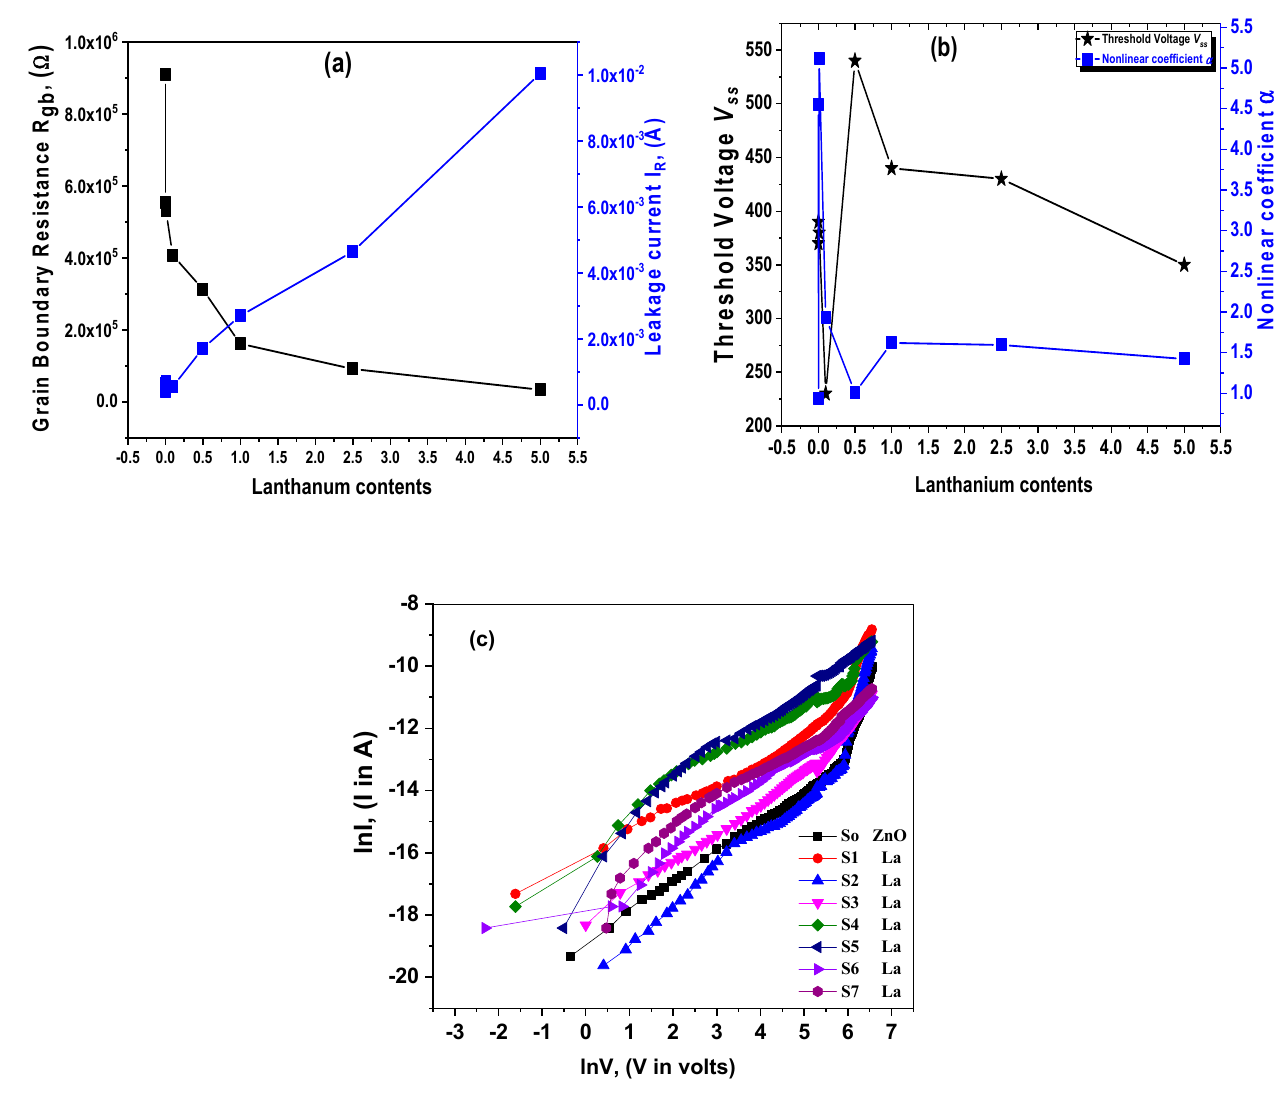
Figure 8. ( a – c ): ( a , b ) The V–I fitted as a function of the lanthanum contents, ( c ) linear relation between lnI and lnV as-prepared La 2 O 3 -ZnO